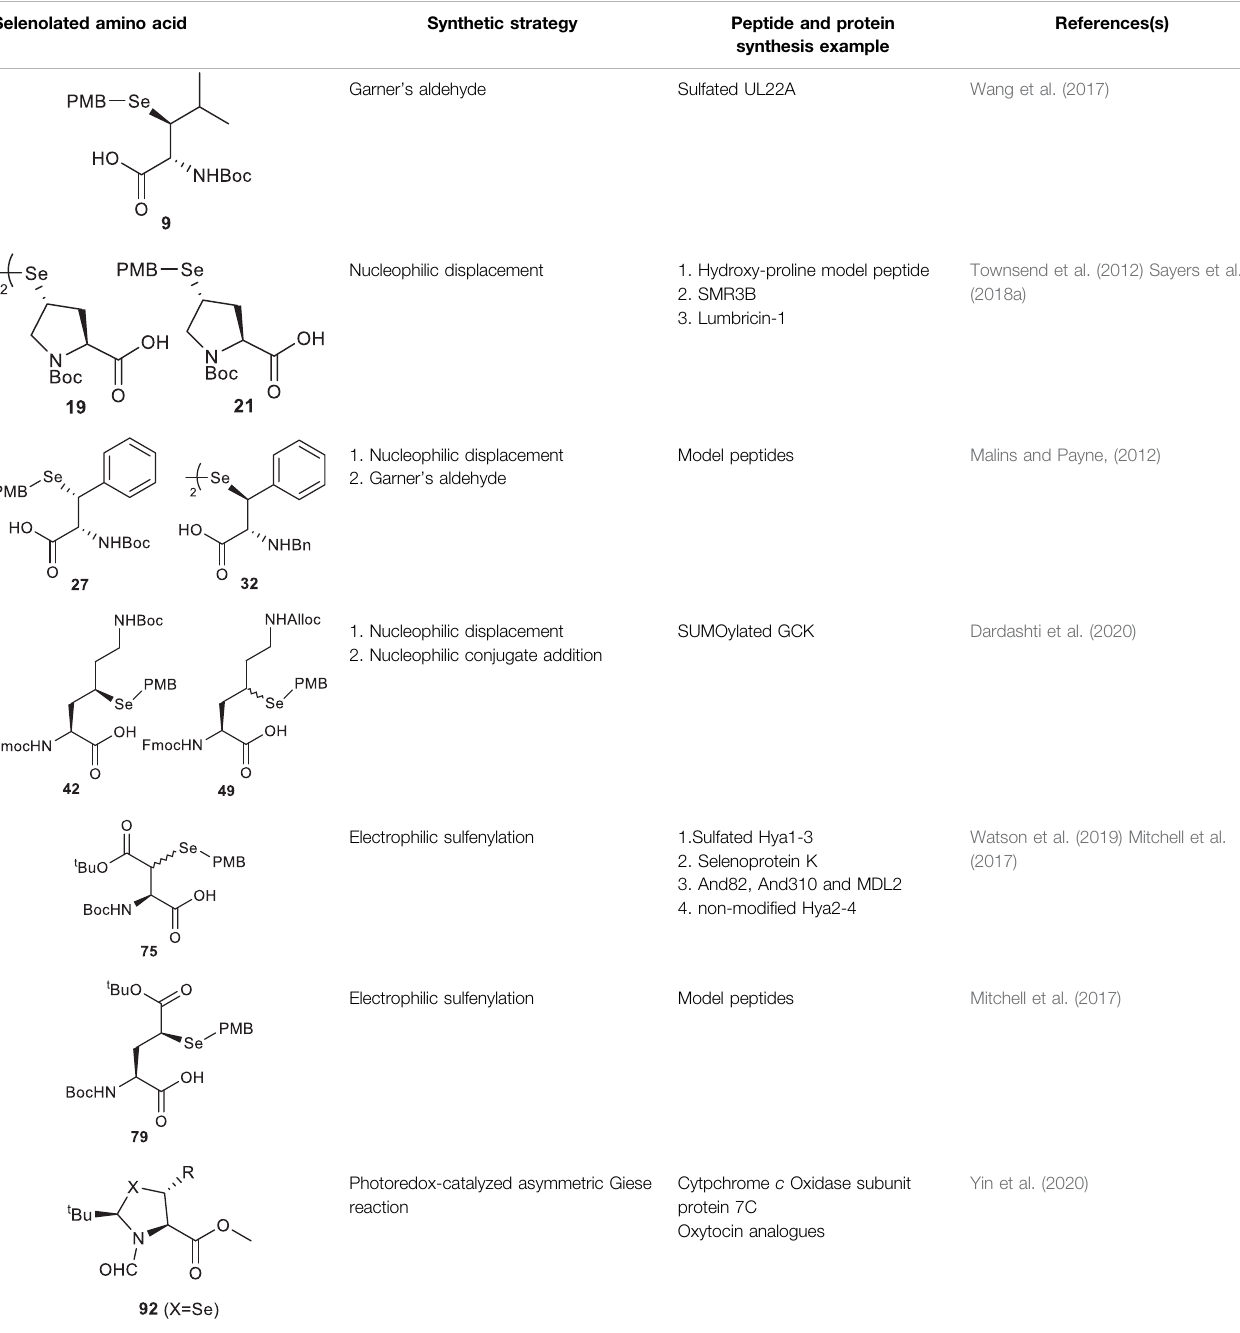
TABLE 2 | Selenol derived amino acids and the relevant synthesis examples described in this article. Selenolated amino